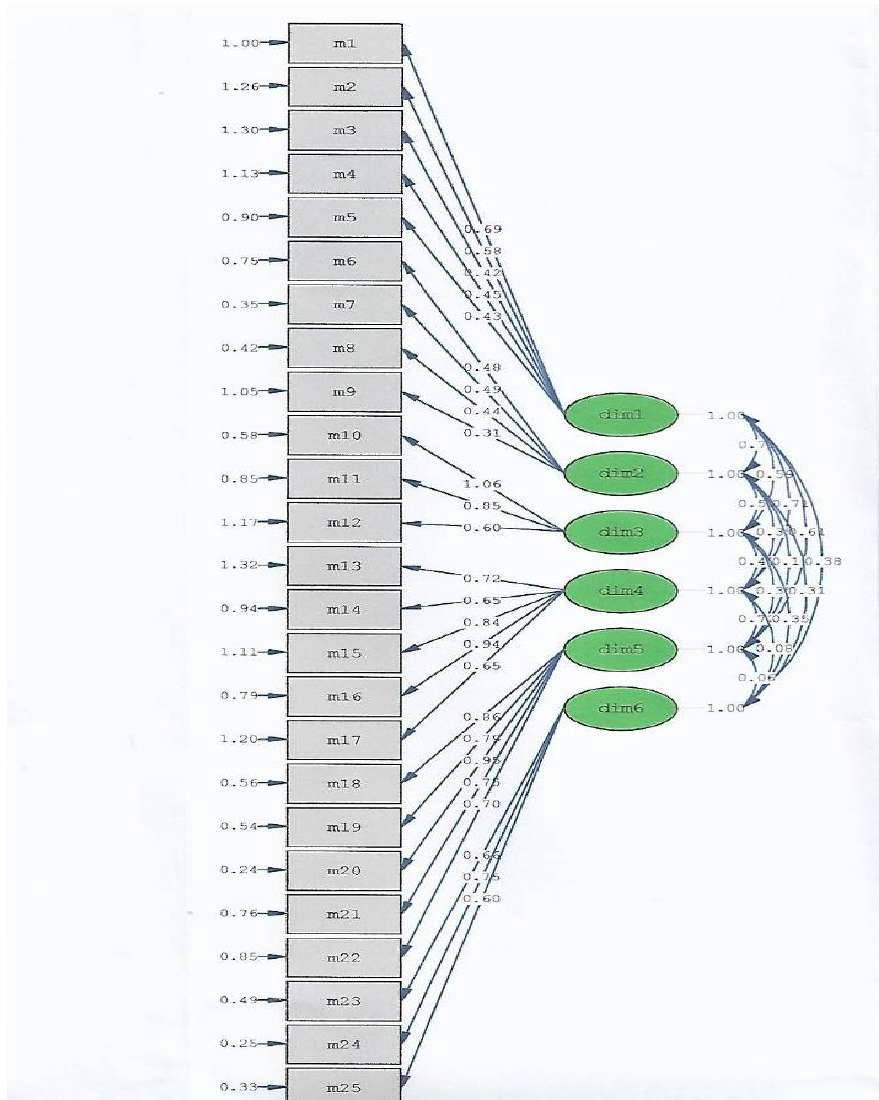
Figure 2. A confirmatory analysis of the P-MFSMS.